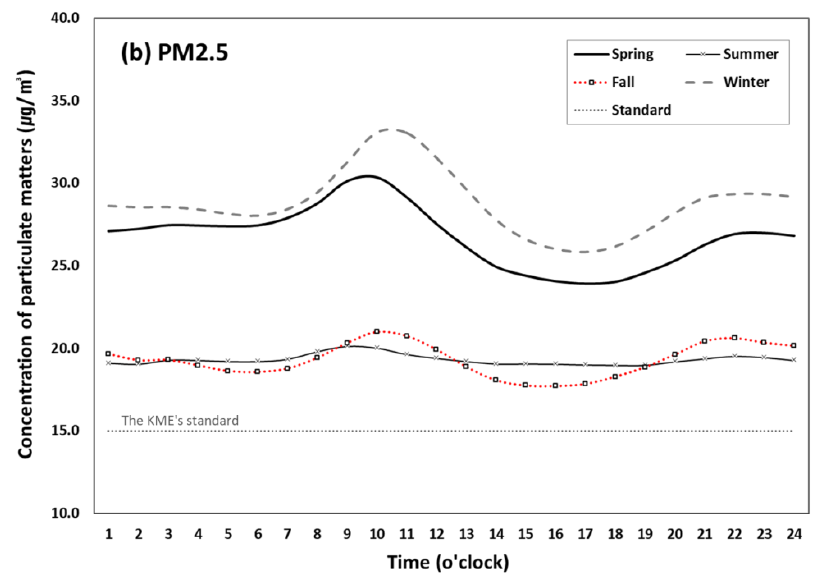
Figure 3. Diurnal variation of PM concentrations (µg/m 3 ) by season (2015–2019).